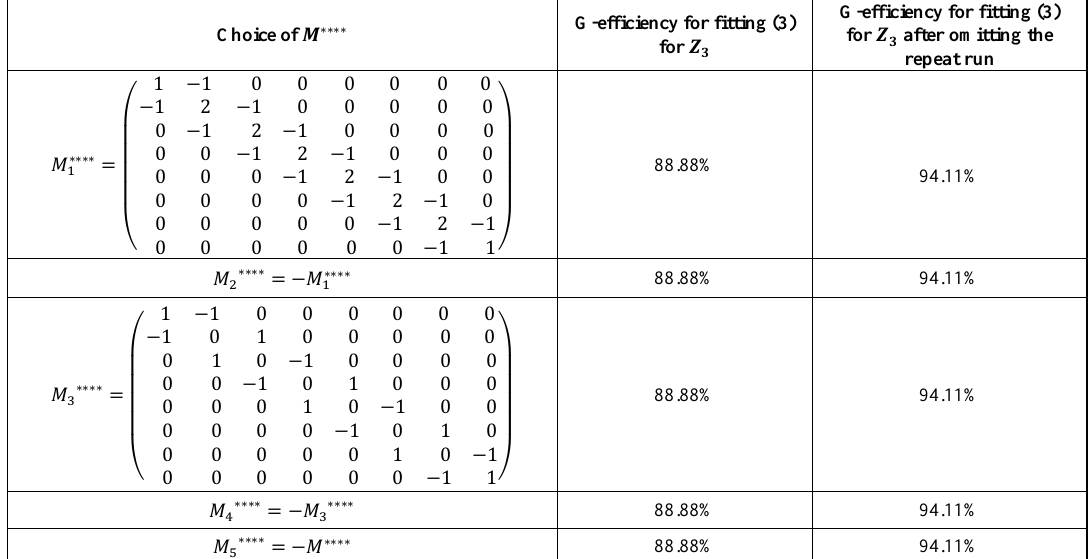
Table 5. G-efficiency of unconstrained mixture designs corresponding to different choices of 𝑀 ∗∗∗∗ for fitting Scheffé’s linear model G-efficiency for fitting (3) G-efficiency for fitting (3) Choice of 𝑴 ∗∗∗∗ for 𝒁 𝟑 after omitting the for 𝒁 𝟑 repeat